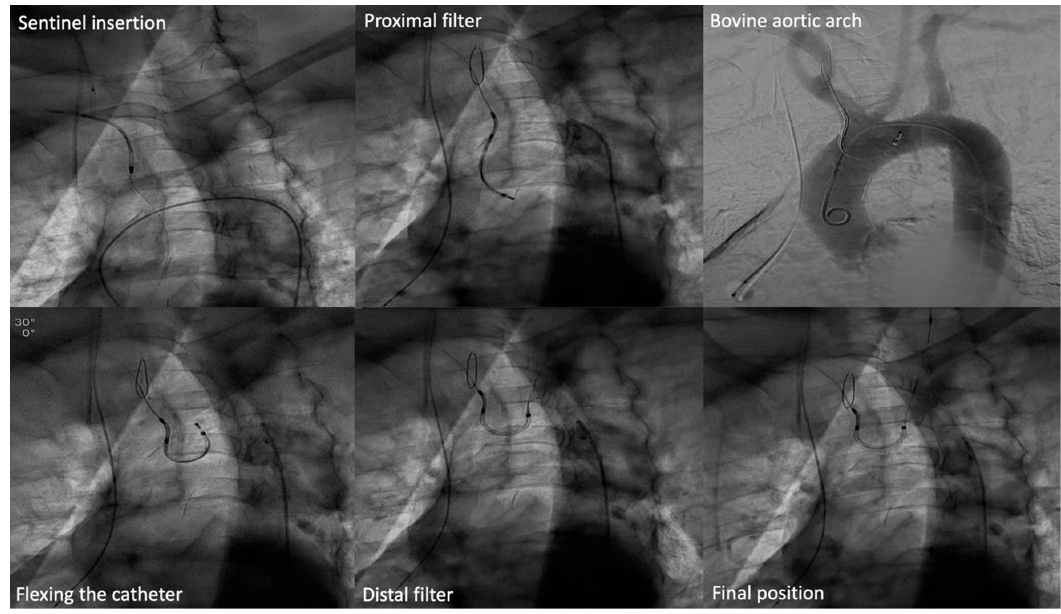
Figure 1. Sentinel insertion in a bovine aortic arch anatomy.